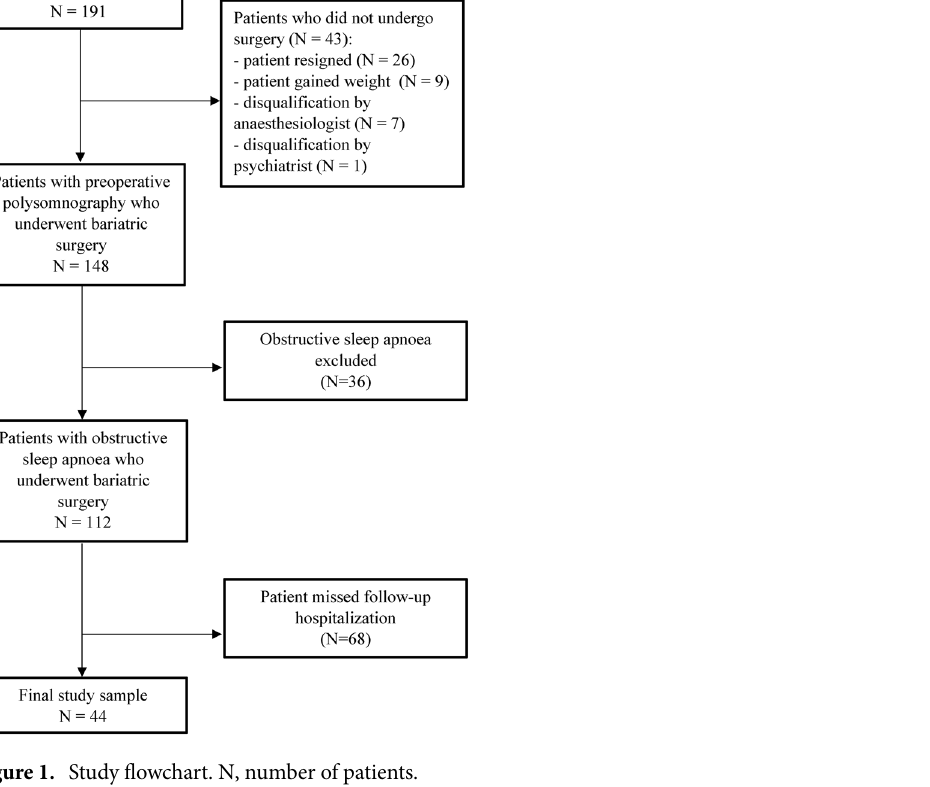
Figure 1. Study flowchart. N, number of